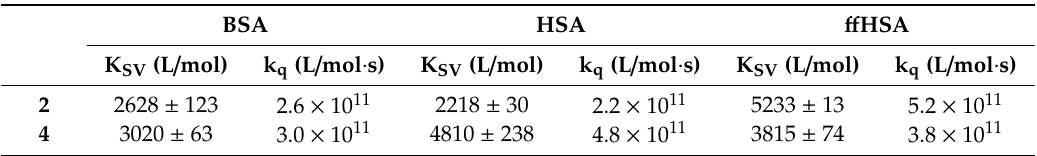
Table 1. Stern–Volmer constant K SV and kinetic constant of bimolecular quenching k q according to Stern–Volmer analysis.